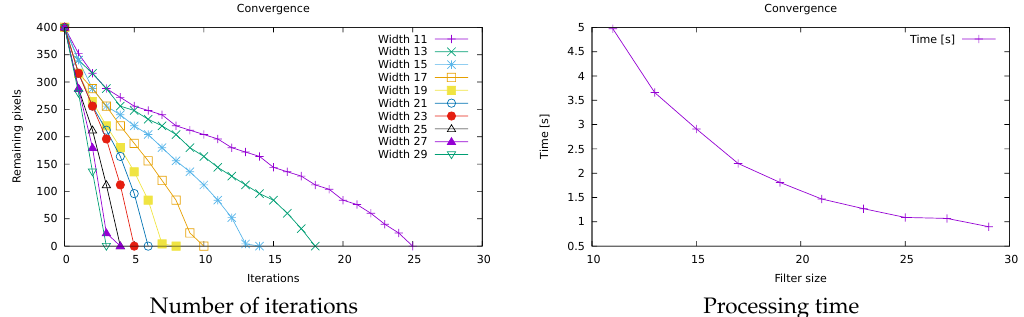
Figure 8. Number of iterations and processing time needed to remove a 20 × 20 pixels square depending on the filter size on a 100 × 100 image with background with different values for the four